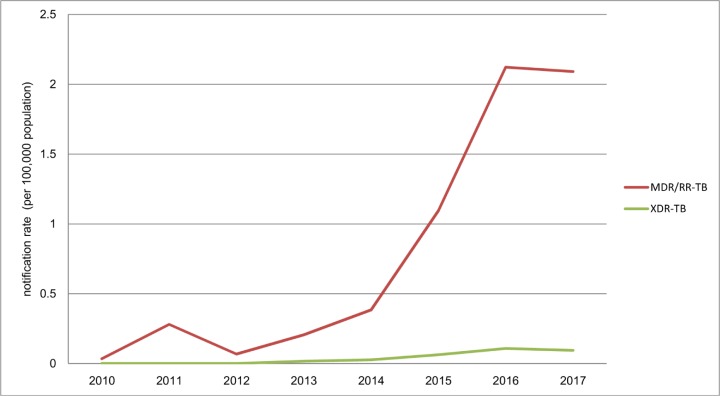
The trend of DR-TB notification rate from 2010 to 2017.